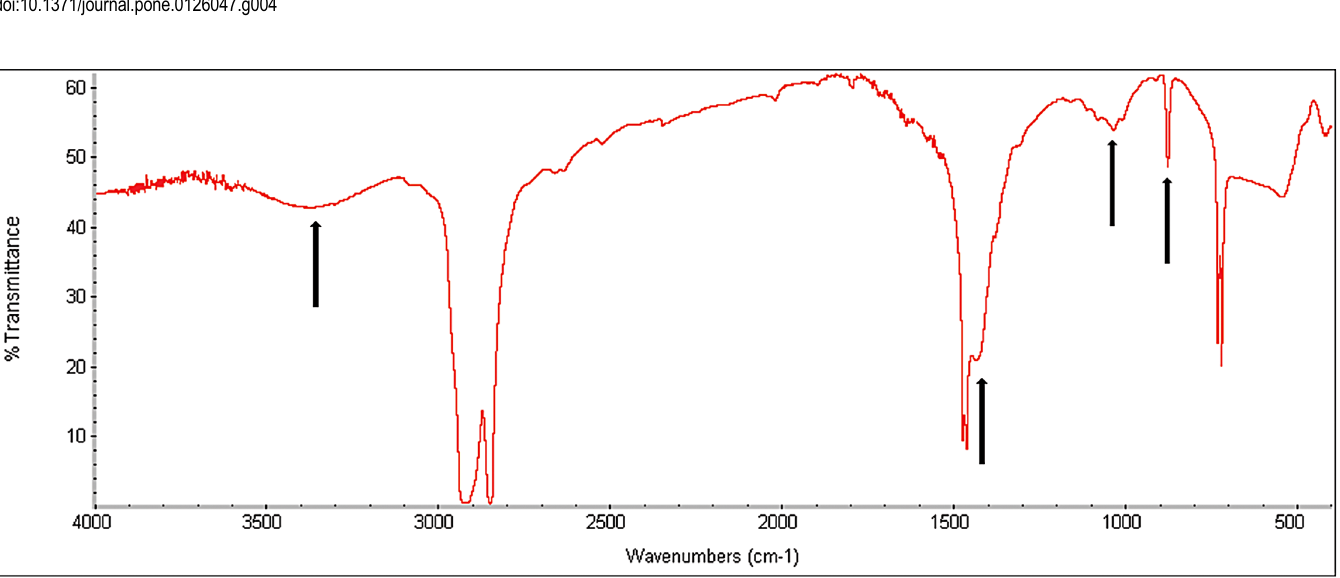
Fig 5. Espectrum of Fourier transform infrared spectroscopy of the green polyethylene after 120 d of exposure to sunlight and 90 d of incubation with Pleurotus ostreatus . The arrows show the bands that were observed after the fungal incubation (See also Fig 1).